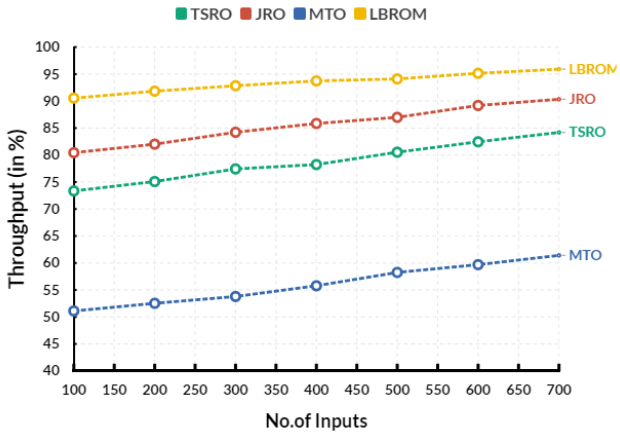
Figure 4. Comparison of network throughput.